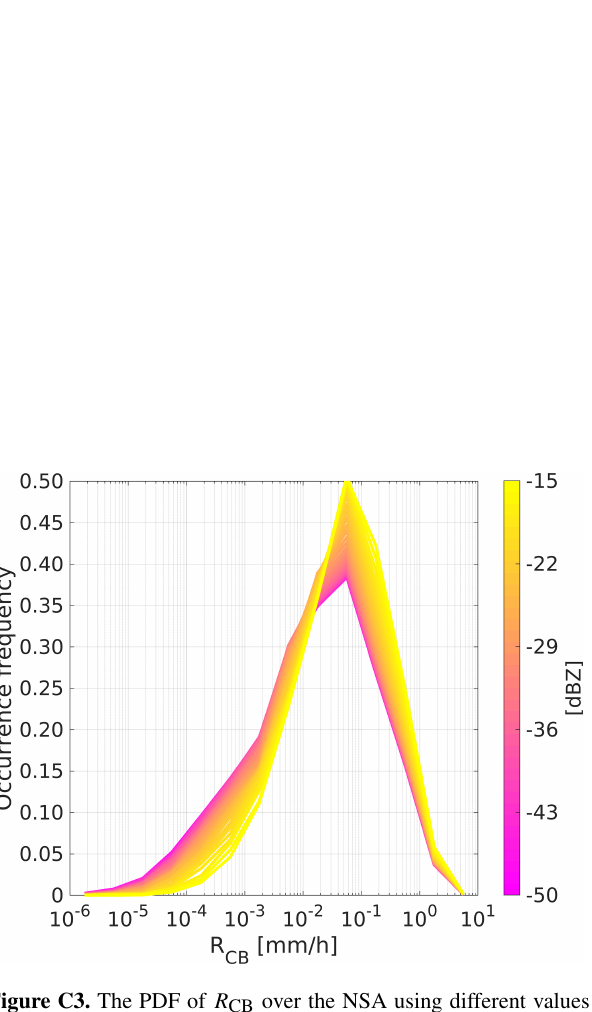
Figure C3. The PDF of R CB over the NSA using different values of Z e at 1km (color scale). See Appendix C for min